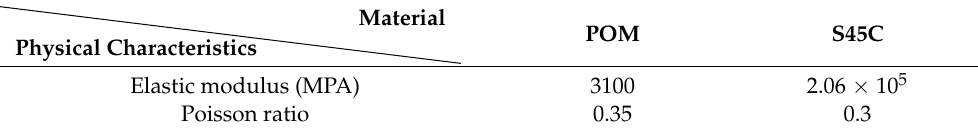
Table 2. The physical characteristics of the materials for worm and helical gear.